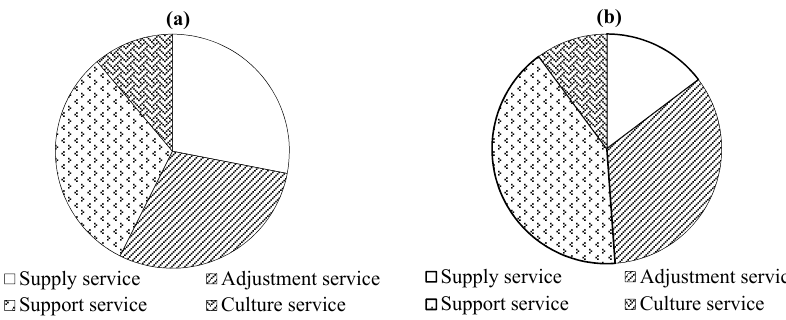
Figure 4. Proportion of supply services, adjustment services, support services, and culture services: ( a ) before optimization; and ( b ) after optimization.